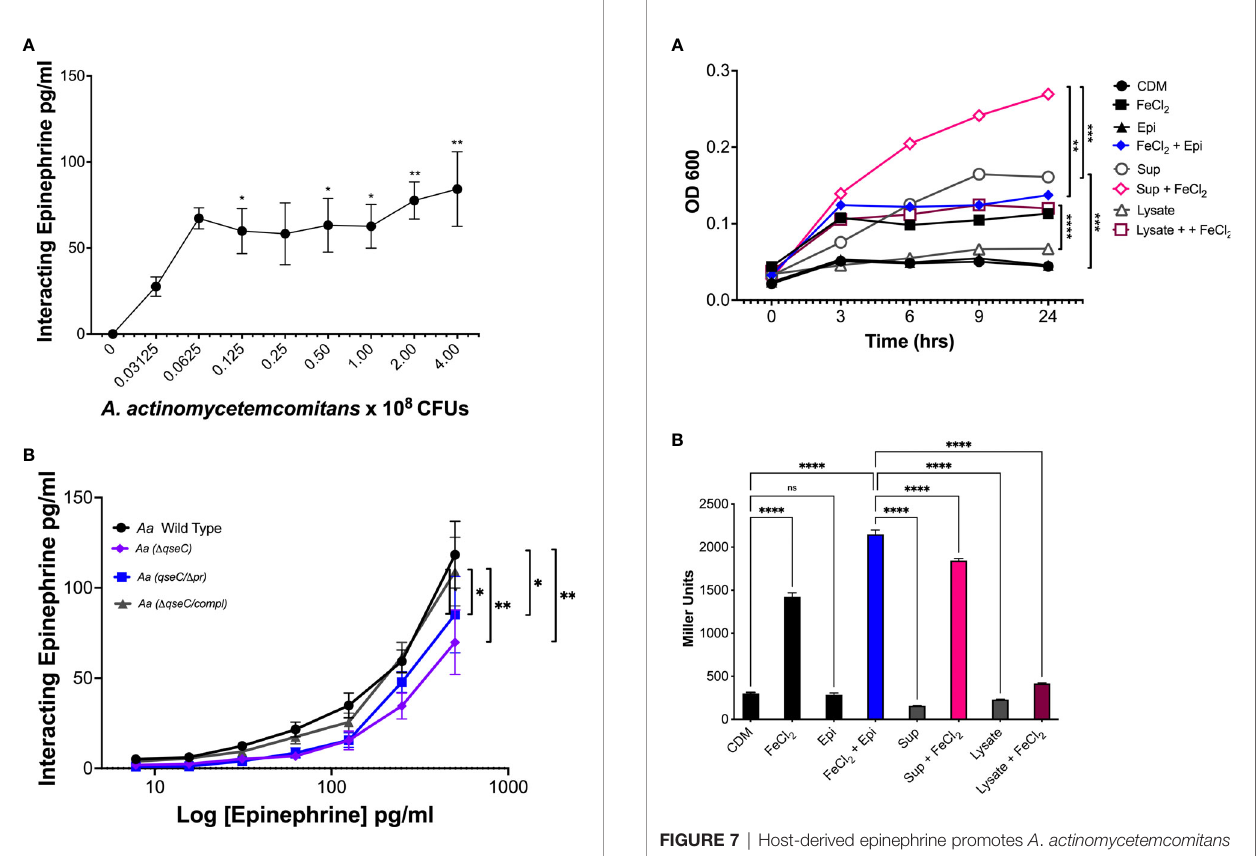
FIGURE 6 | A . actinomycetemcomitans interacts with epinephrine in a QseC-dependent manner. The interaction of epinephrine and A . actinomycetemcomitans was determined by incubation of increasing colony- forming units (CFUs) of A . actinomycetemcomitans with 250 pg/ml of recombinant epinephrine. Associated epinephrine was plotted against increasing CFUs of Aa (A) . Requirement of QseC for epinephrine interaction with A. actinomycetemcomitans was determined by incubation of the bacterium with increasing concentrations of recombinant epinephrine (0 – 500 pg/ml) (B) . Epinephrine levels were measured by ELISA and plotted as the mean ± SD of fi ve independent experiments. Statistical differences among experimental conditions were analyzed by ordinary one-way ANOVA (A) or two-way ANOVA (B) , followed by Tukey ’ s post-test. * p < 0.05. ** p <